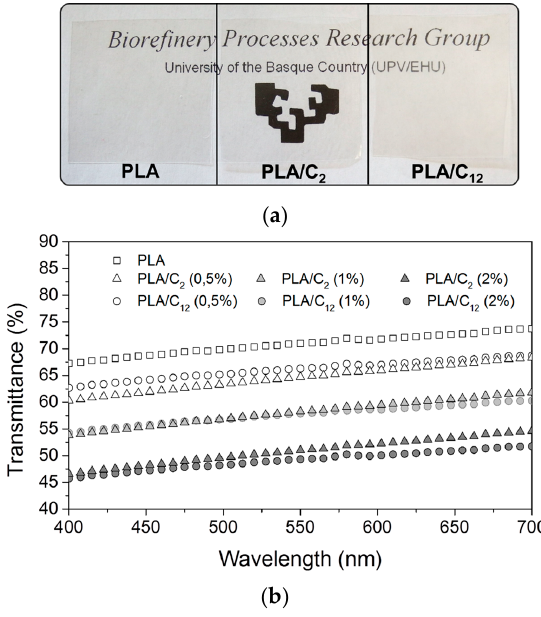
Figure 6. Photographs of PLA, PLA/C 2 0.5 and PLA/C 12 0.5 nanocomposite films ( a ); and transmittance traces of PLA film and PLA/C 2 and PLA/C 12 nanocomposite films ( b ).